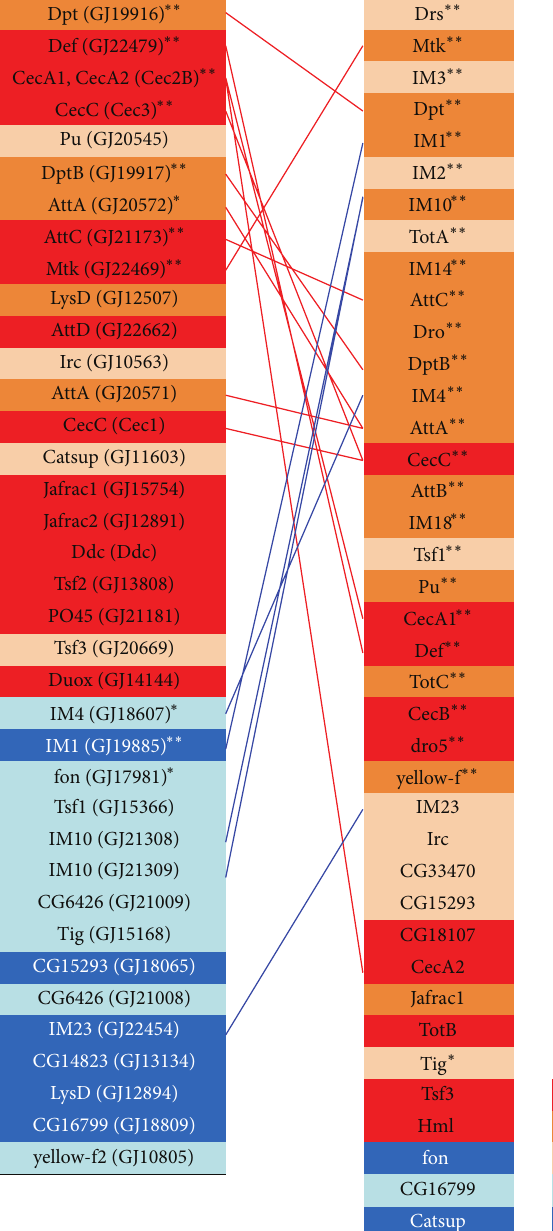
many unidentified genes in D. virilis . To examine